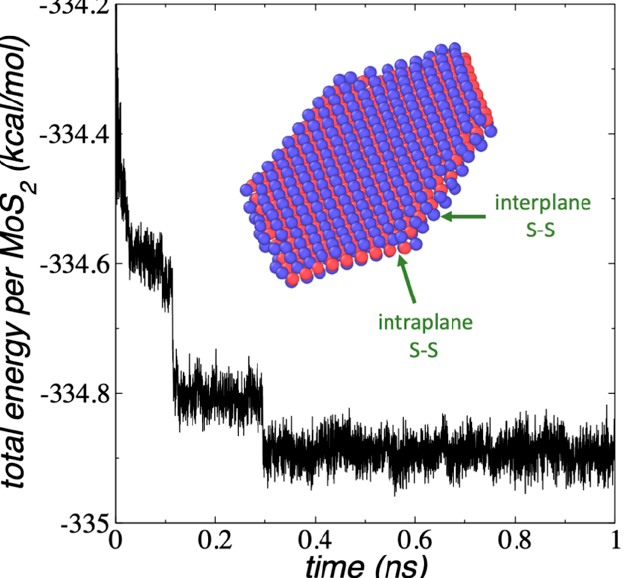
Figure 1. E #MoS2 of 1L Mo 243 S 486 flake as a function of simulation time, under vacuum and NVT conditions at 298.15 K. The inset snapshot corresponds to the equilibrated conformation of the flake and shows the formation of intra- and inter-plane S–S bonds. Blue and red spheres represent Mo and S atoms, respectively.